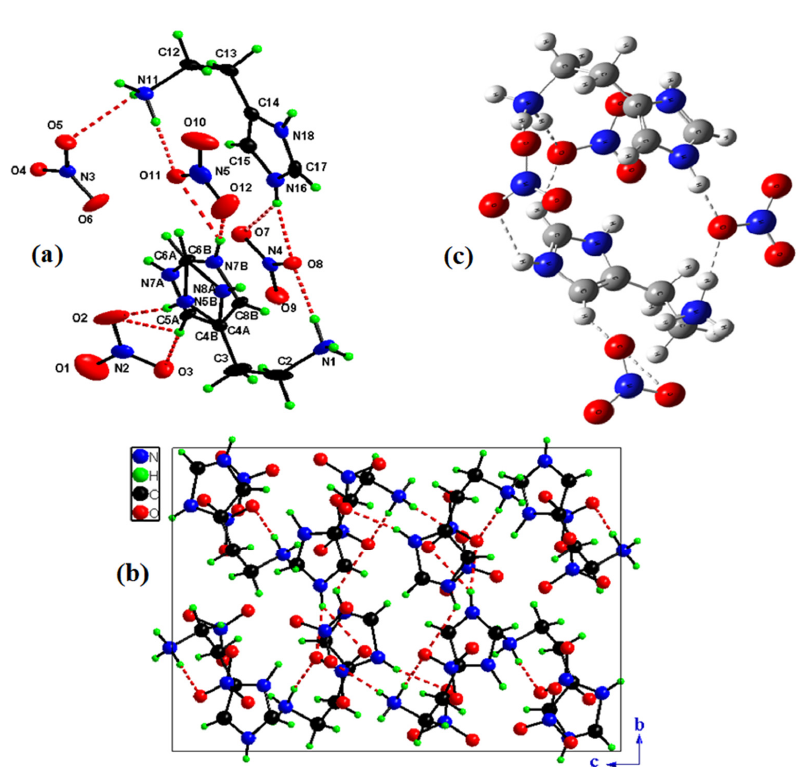
Figure 1. Asymmetric unit of HTN with the atom-labeling scheme ( a ). Projection of HTN structure along the 𝑎⃗ axis ( b ). Optimized structure of (C 5 H 11 N 3 )(NO 3 ) 2 molecule calculated by using B3LYP/ LanL2DZ level ( c )